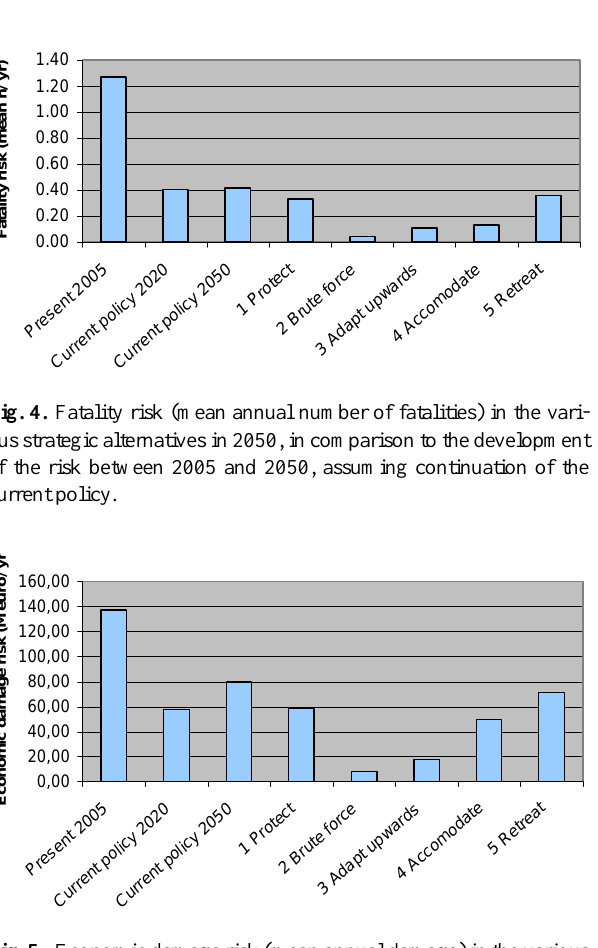
Fig. 5. Economic damage risk (mean annual damage) in the various strategic alternatives in 2050, in comparison to the development of the risk between 2005 and 2050, assuming continuation of the current policy.